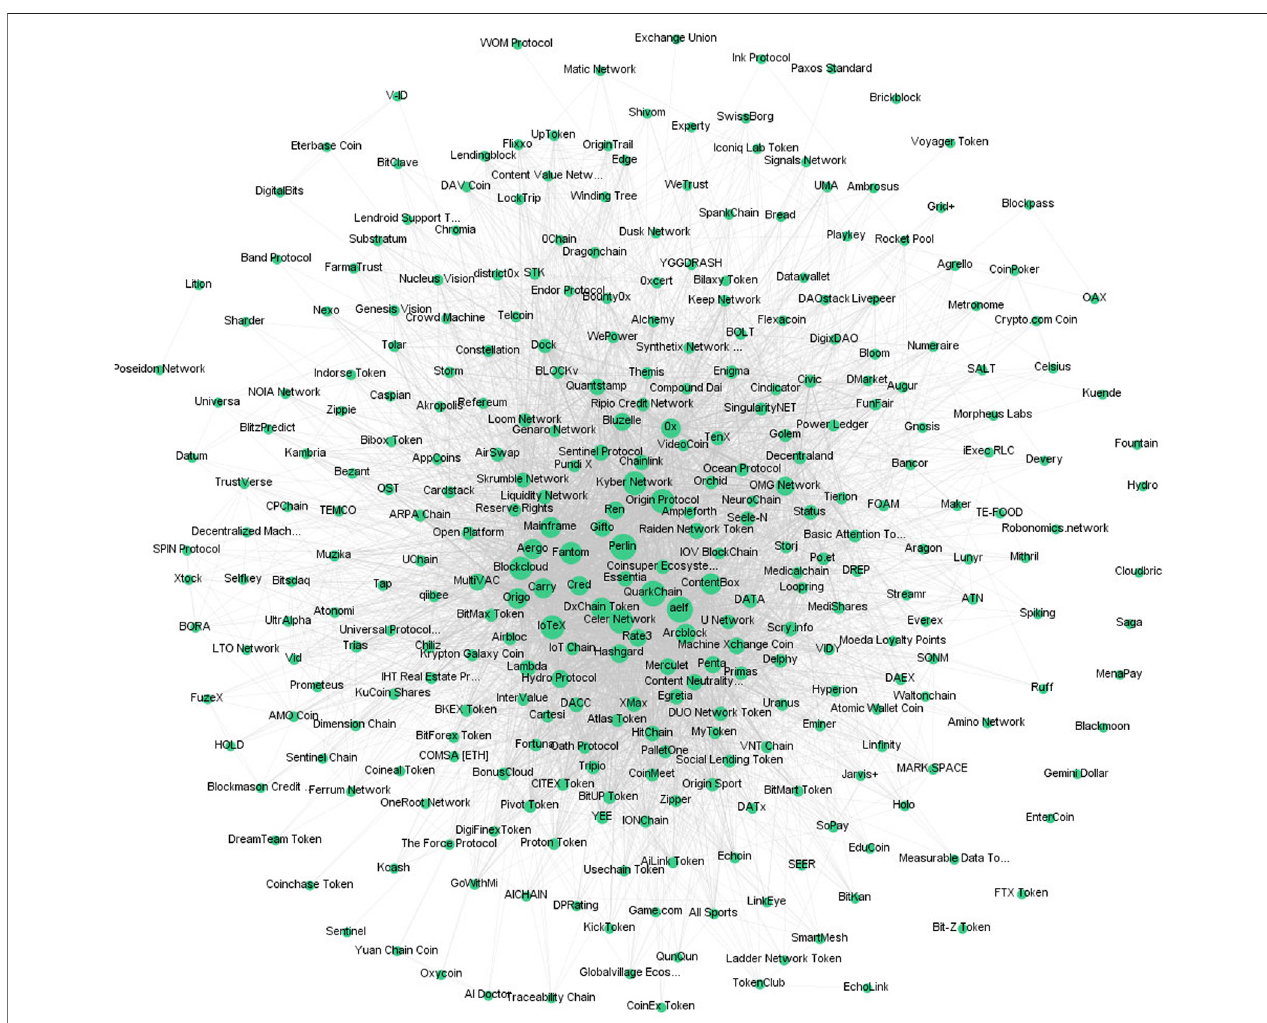
FIGURE 1 | Co-investment network of ERC-20 Tokens. The sizes of the nodes are scaled by their degrees.